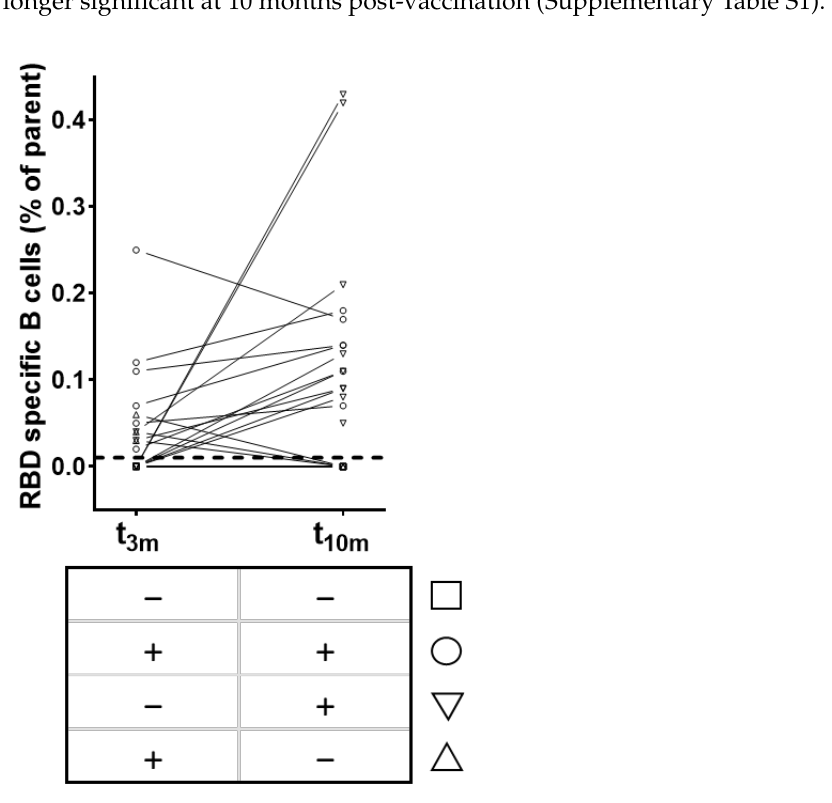
Figure 4. Patterns of circulating RBD-specific B cells after BNT162b2 vaccination ( n = 23). Squares = subjects without RBD-specific B cells at both t 3m and t 10m . Upward triangles = subjects with RBD- specific B cells at t 3m only. Downward triangles = subjects with RBD-specific B cells at t 10m only. Circles = subjects with RBD-specific B cells at both t 3m and t 10m . Dashed line = assay-specific cut-off. Abbreviations: RBD = receptor-binding domain, parent = CD3 − /CD19 + /Zombie − cells, pre = baseline sampling moment before vaccination, 3m = 3 months after baseline, 10m = 10 months after